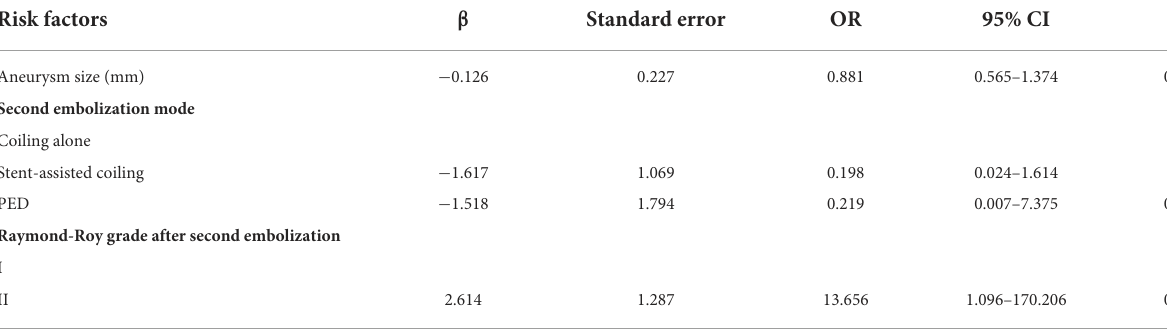
TABLE 4 Multivariate analysis of risk factors affecting recurrence after second embolization.